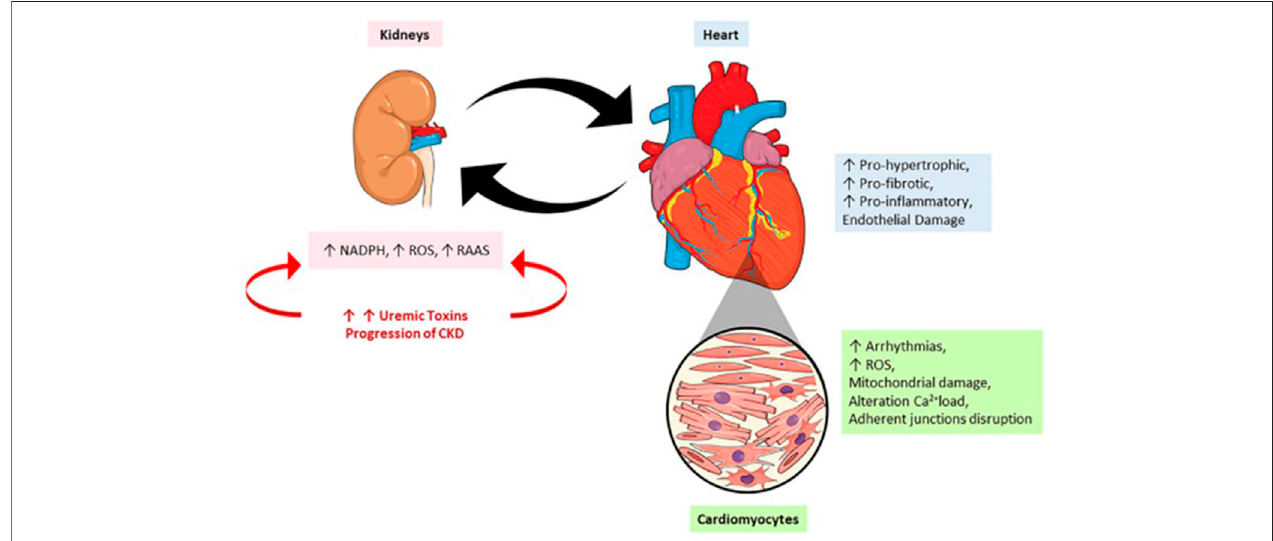
FIGURE 1 | The crosstalk between heart and kidney: contributions to uremic toxins. During the progression of a renal lesion there is an increase in the circulatory levels of uremic toxins accompanied by an increase in renin-angiotensin-aldosterone system (RAAS) activity and reactive oxygen species (ROS). On the other hand, the heart responds to kidney injury by the onset of pro-oxidant, pro-in fl ammatory effects leading to mitochondrial damage, alterations in calcium loading, arrhythmias, and cardiac remodeling.